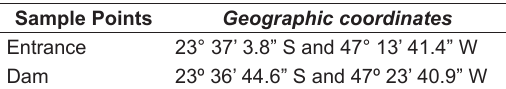
Figure 1. Location of Itupararanga Reservoir and sampling points. P1 = dam and P2 = Entrance. Table 1. Geographic coordinates of the sample